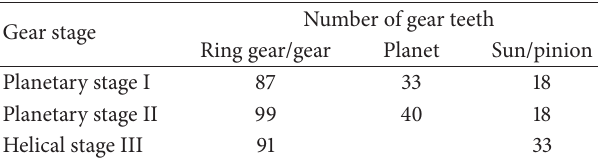
Table 4: Vestas V90-3MW gear teeth information.